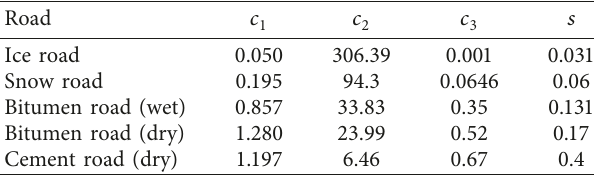
Table 1: Tire typical road parameters and optimal slip rate.